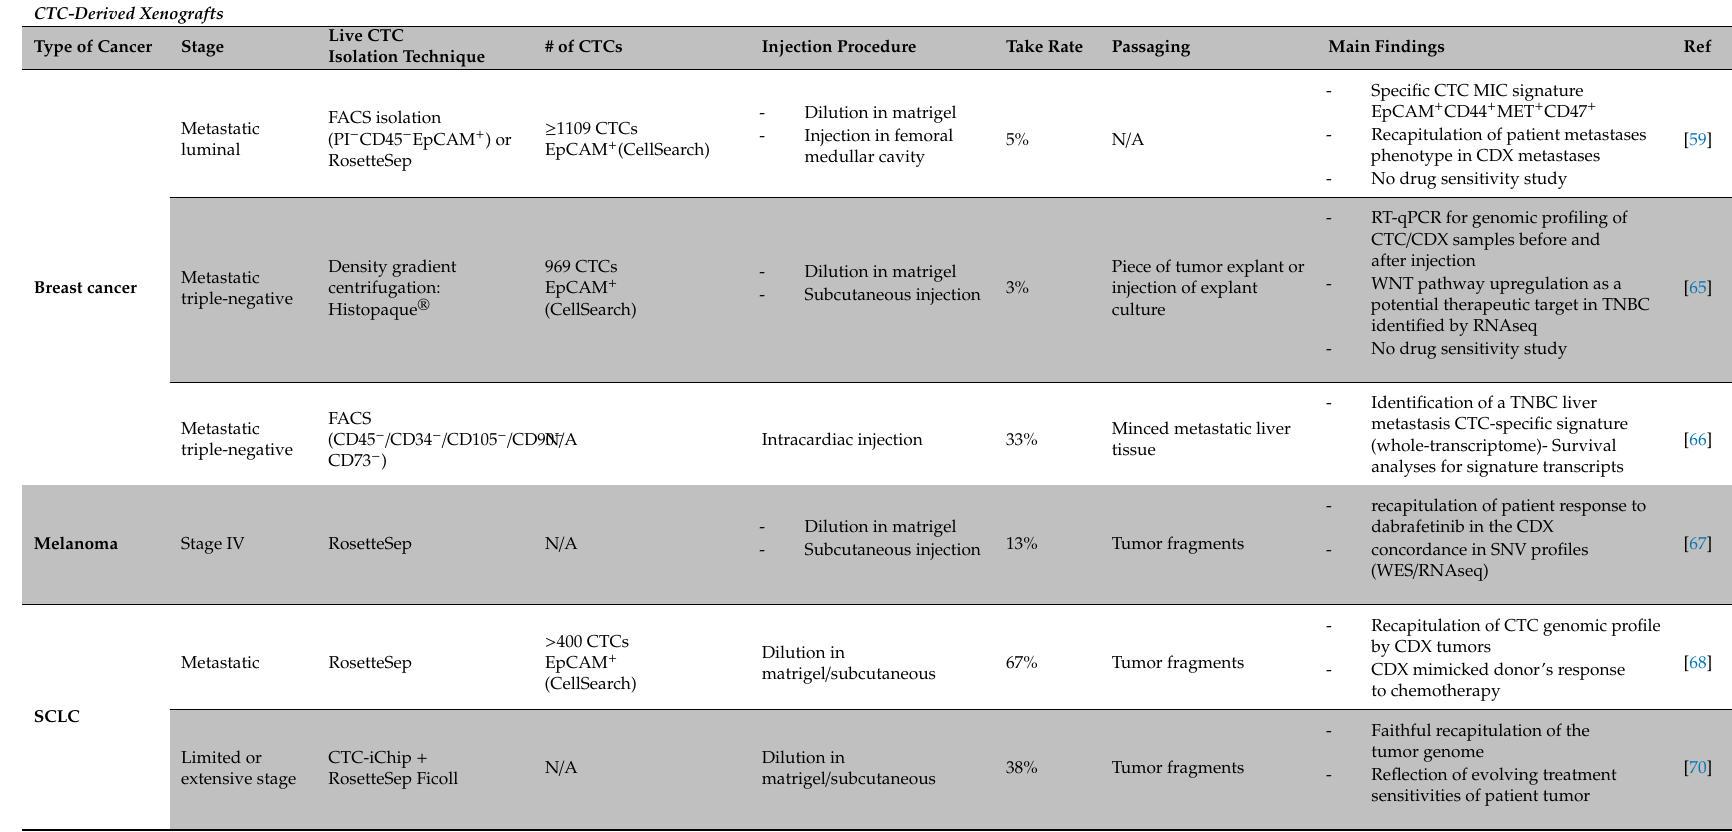
Table 1. Overview of in vivo circulating tumor cell (CTC)-derived models established to